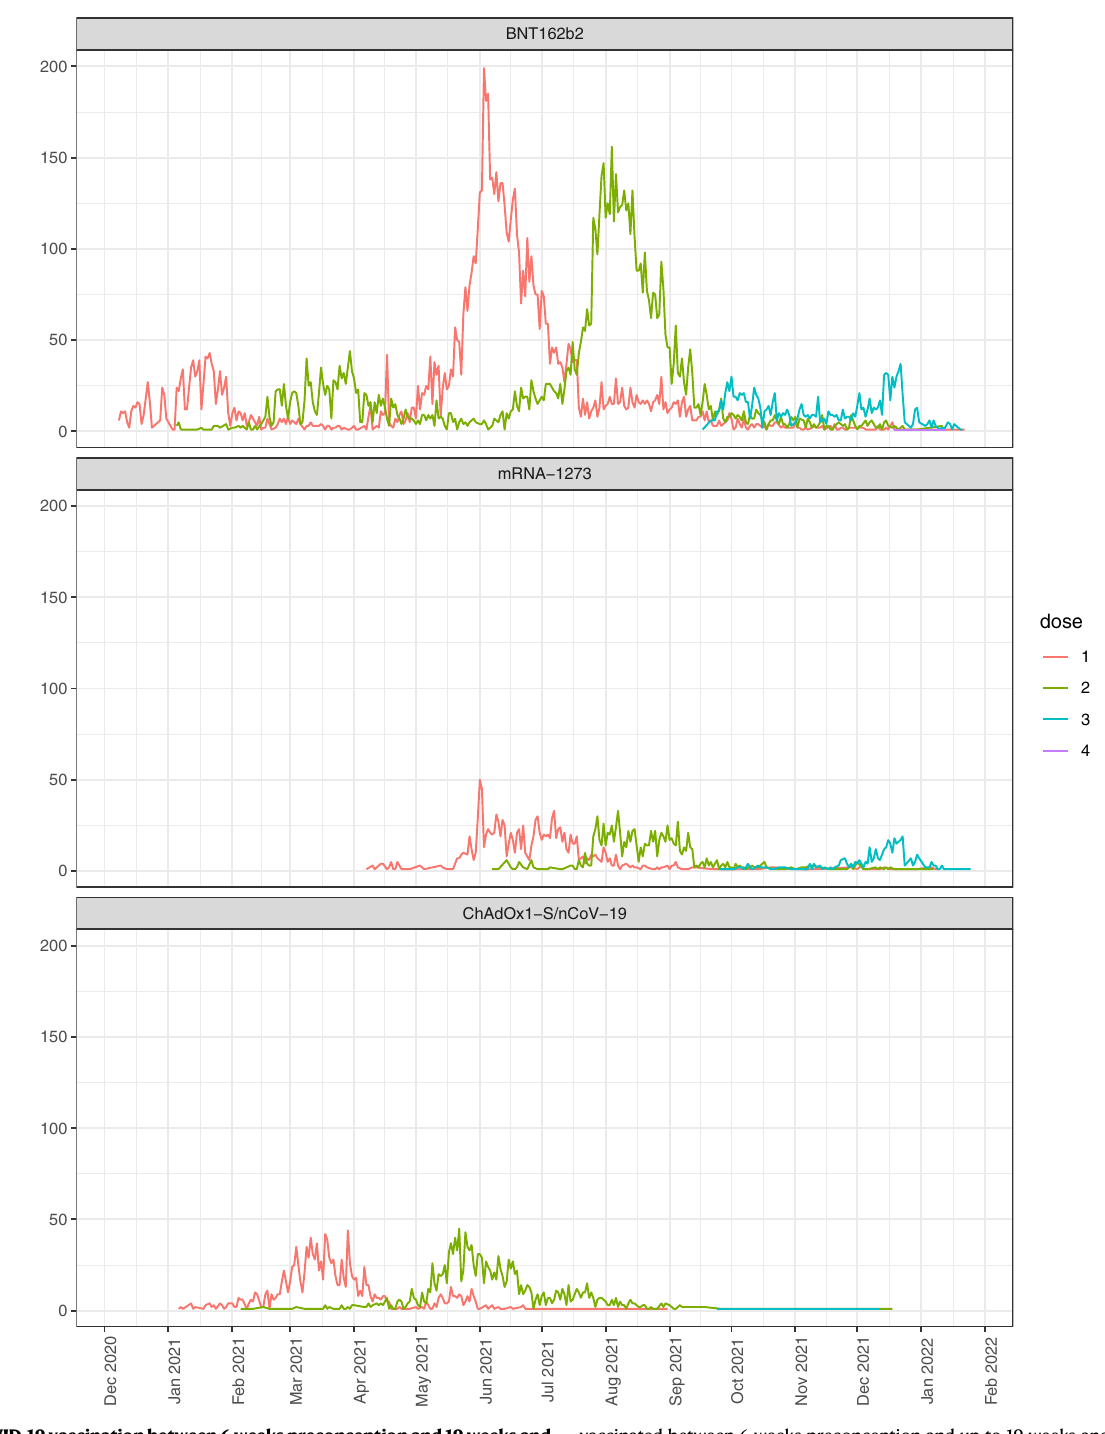
vaccinated between 6 weeks preconception and up to 19 weeks and 6 days gesta- tion by calendar time, dose number and type of